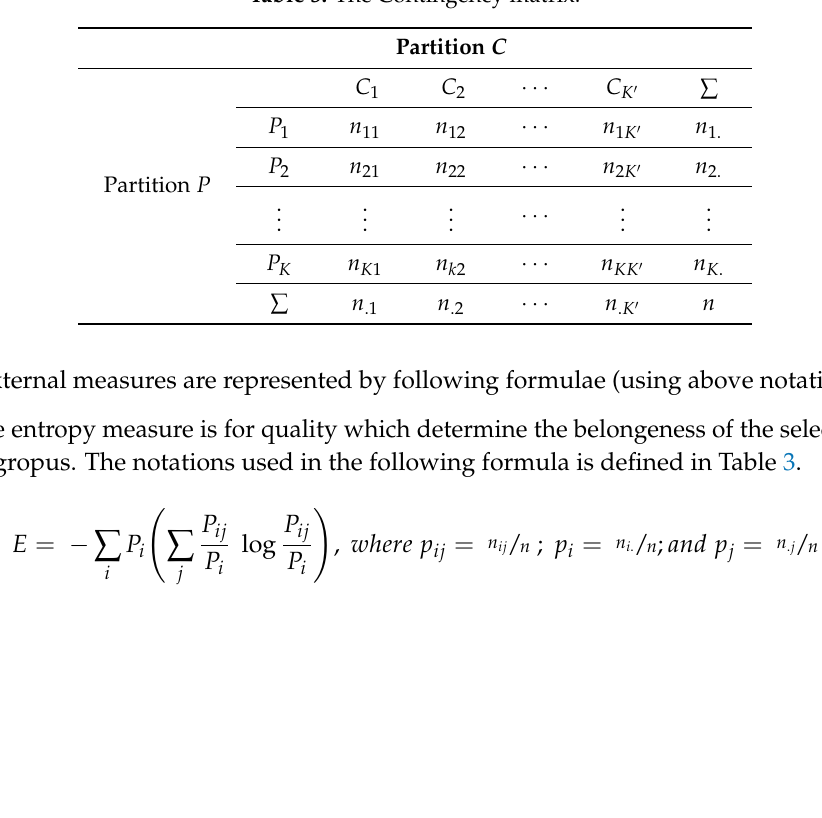
Table 3. The Contingency